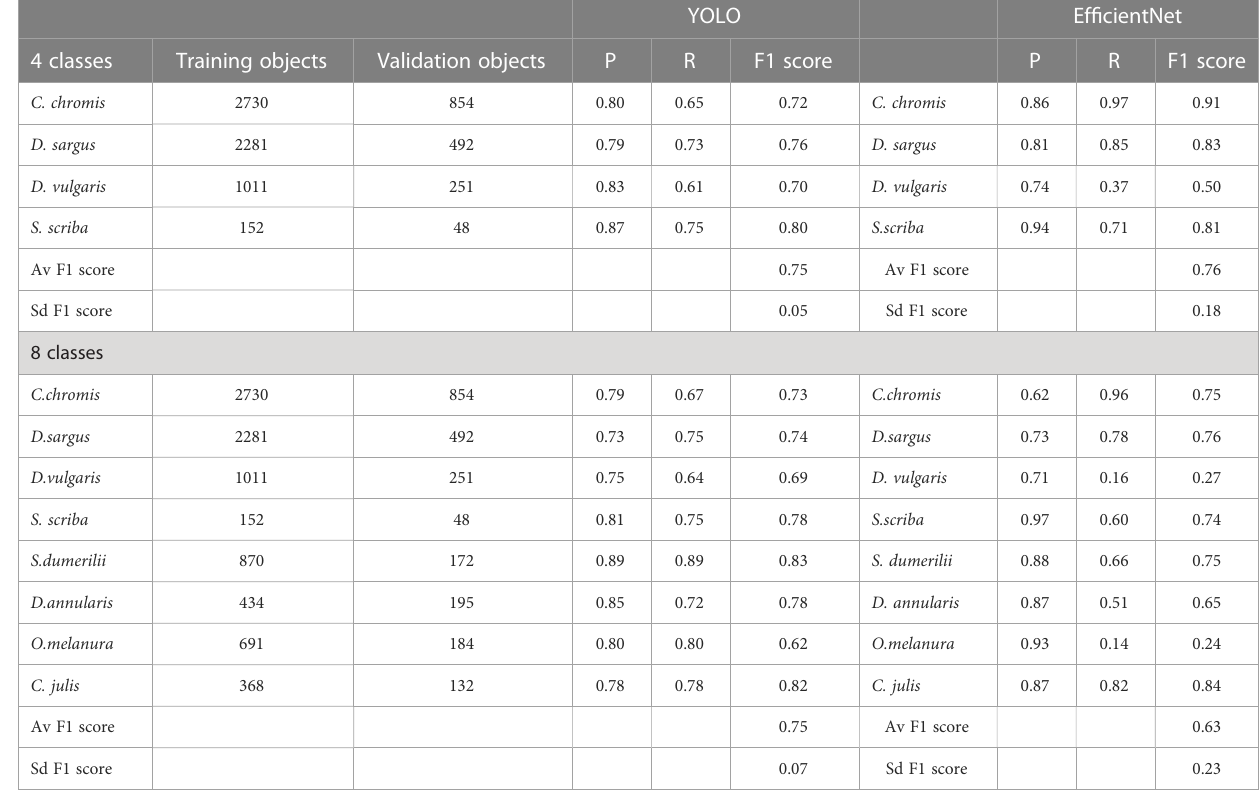
TABLE 5 Results of comparable classi fi cation metrics between YOLO and Ef fi cientNet using either 4 or 8 classes.